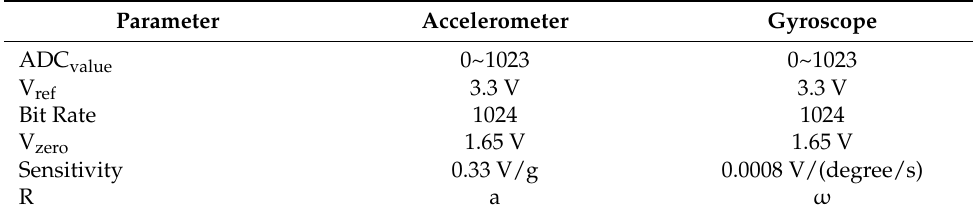
Table 3. Parameters of accelerometer and